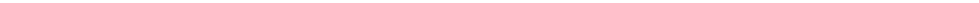
segment is interpreted as the depth to the basement rock (5 to 11 km). This estimate was constrained by previous works (Murauchi et al. 1973; Rangin 1989). Based on the seismic refraction and reflection study of Murauchi